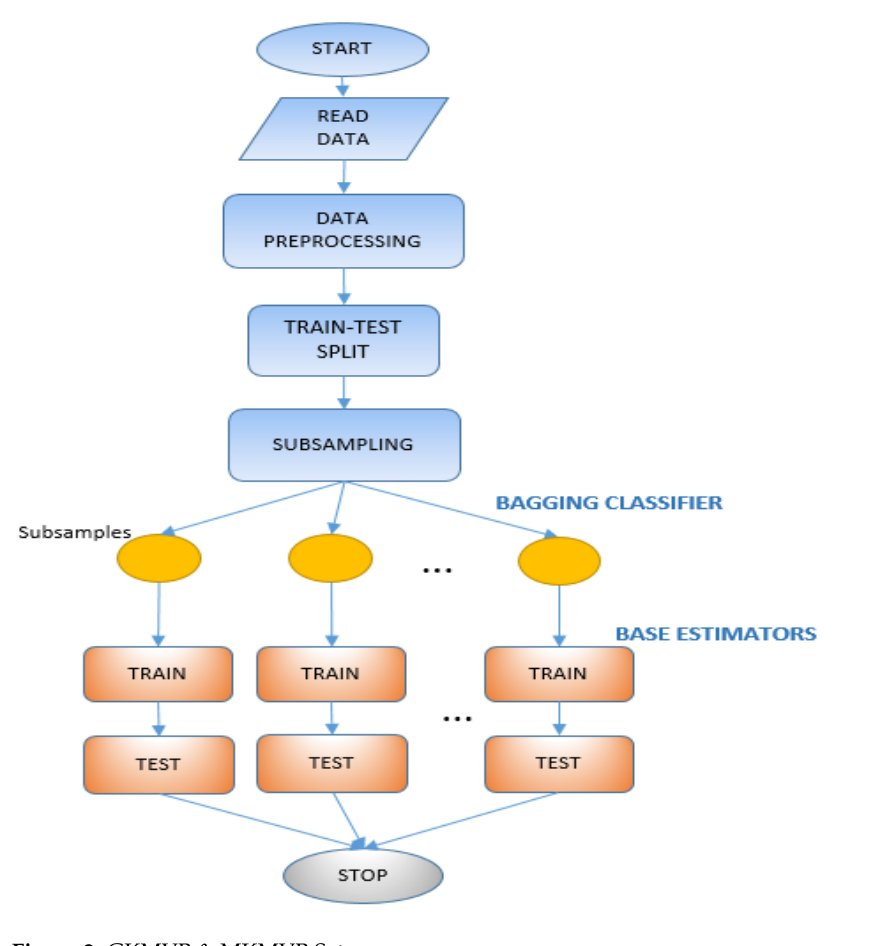
Figure 2. GKMVB & MKMVB